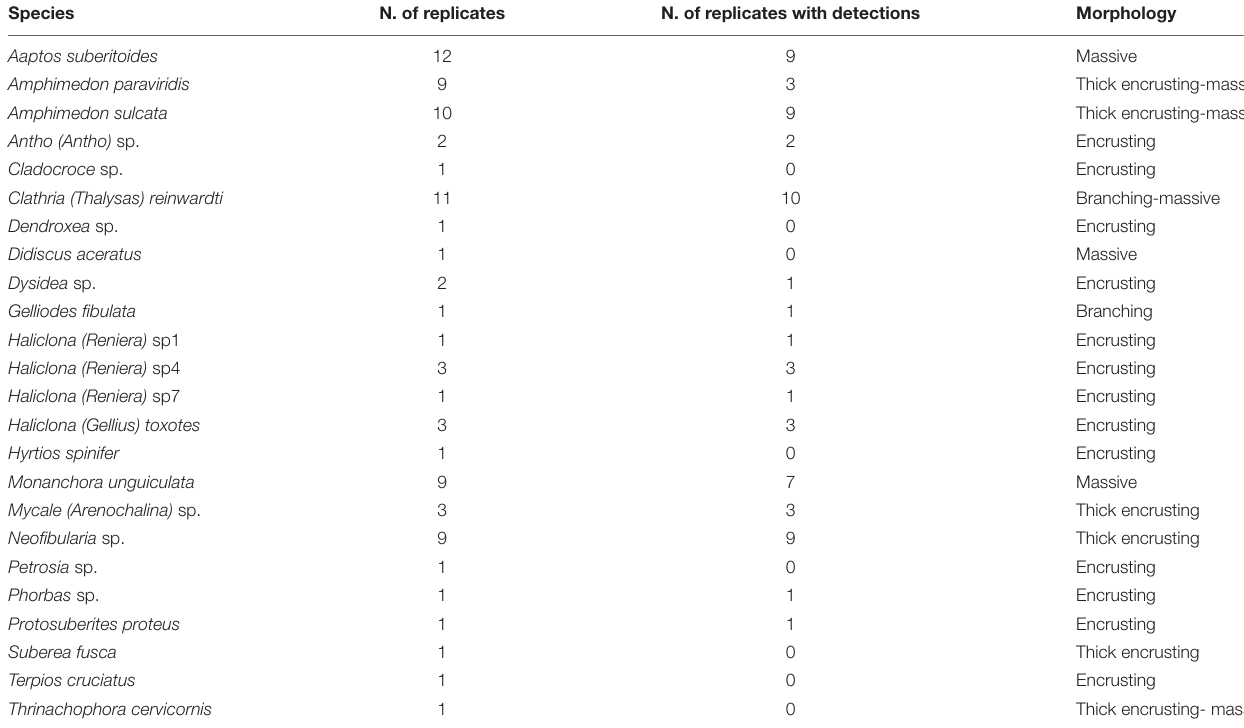
TABLE 1 | Sponge species collected in Nha Trang Bay (Vietnam). Species N. of